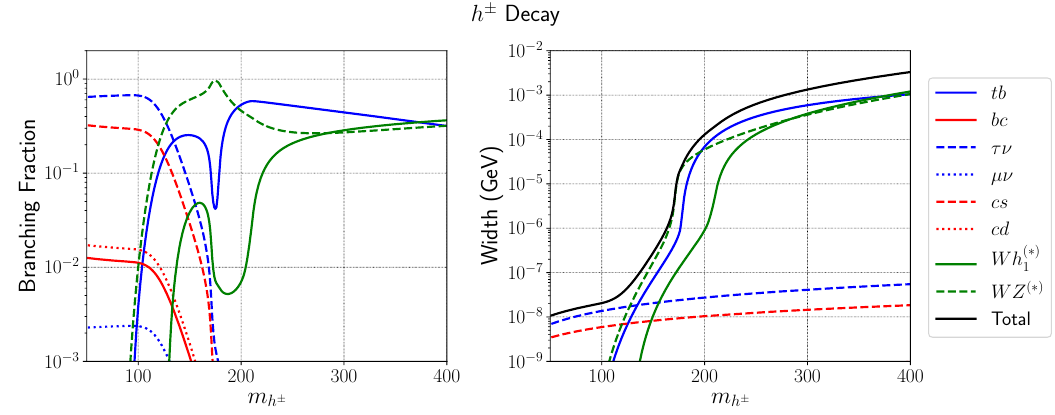
Figure 8. Branching fractions (left panel) and partial widths (right panel) for the decay of h (cid:22) 2 = 100 2 GeV 2 , v (cid:6) = 1 GeV, and b 4 = 1. The peak at m h (cid:6) in the neutral scalar mixing angle when the two neutral scalars are nearly degenerate.